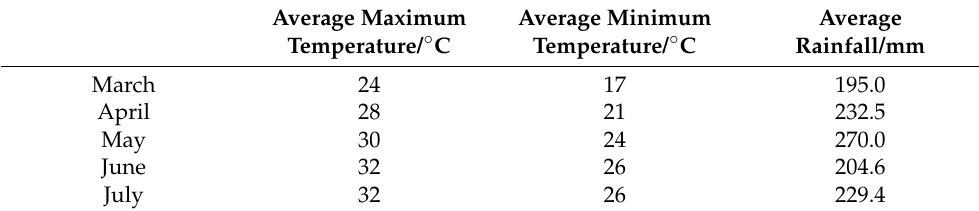
Table 2. Soil fertility tested in two years.